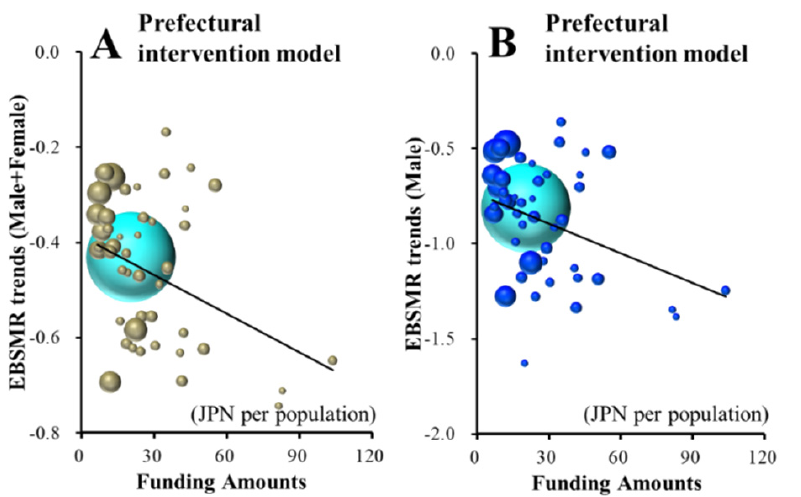
Figure 3. Effects of the amount of funding provided to sub-divisions of EFECBSC on EBSMR trends of Male + Female ( A ) and male ( B ) suicide mortalities caused by economy-related motive were analysed by forward multiple regression analysis. Ordinates indicate EBSMR trends of suicide mortality caused by health-related motives between 2009 and 2018, and abscissas indicate the amount of funding provided to EFECBSC sub-divisions (JPY per population). Light blue, grey and blue spheres indicate national, Male+Female and male EBSMR trends and population sizes, respectively. Black lines indicate the regression lines of significantly positive (decreases suicide mortality) factors. Male+Fe- male EBSMR trends of suicide caused by economy-related motives = − 0.0027 × (prefectural interven- tion model programme) − 0.388. Male EBSMR trends of suicide caused by economy-related motives = − 0.0052 × (prefectural intervention model programme) − 0.738.